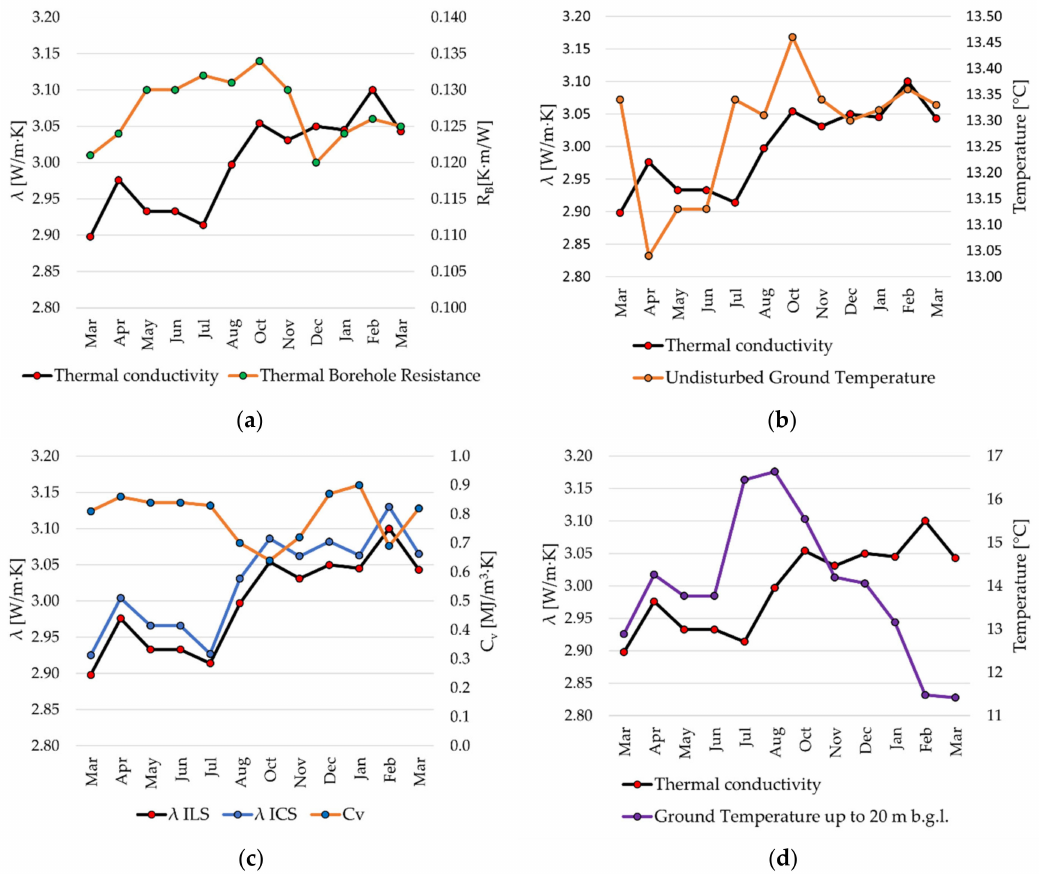
Figure 3. Main parameters of each month plotted vs. thermal conductivity λ using line source model; ( a ) calculated thermal borehole resistance R b ; ( b ) mean measured undisturbed ground temperature; ( c ) calculated thermal conductivity from line- and cylinder-source models, ILS and ICS, and volumetric heat capacity C V ; ( d ) mean temperature from 0 to 20 m below ground level (b. g. l.); connecting lines do not represent collected data but are used for unambiguous